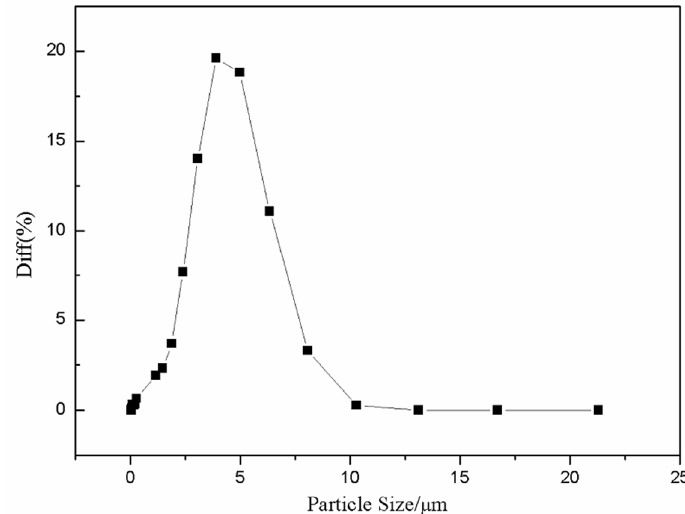
Figure 1. Particle size distribution of alumina powders.